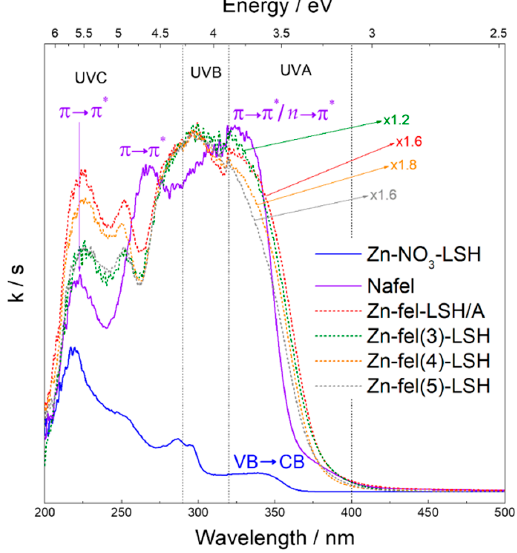
Figure 8. Absorption spectra of Zn-NO 3 -LSH, Zn-fel-LSH/A, Zn-fel(3)-LSH, Zn-fel(4)-LSH, Zn-fel(5)-LSH, and Nafel salt (NaC 10 H 9 O 4 ).